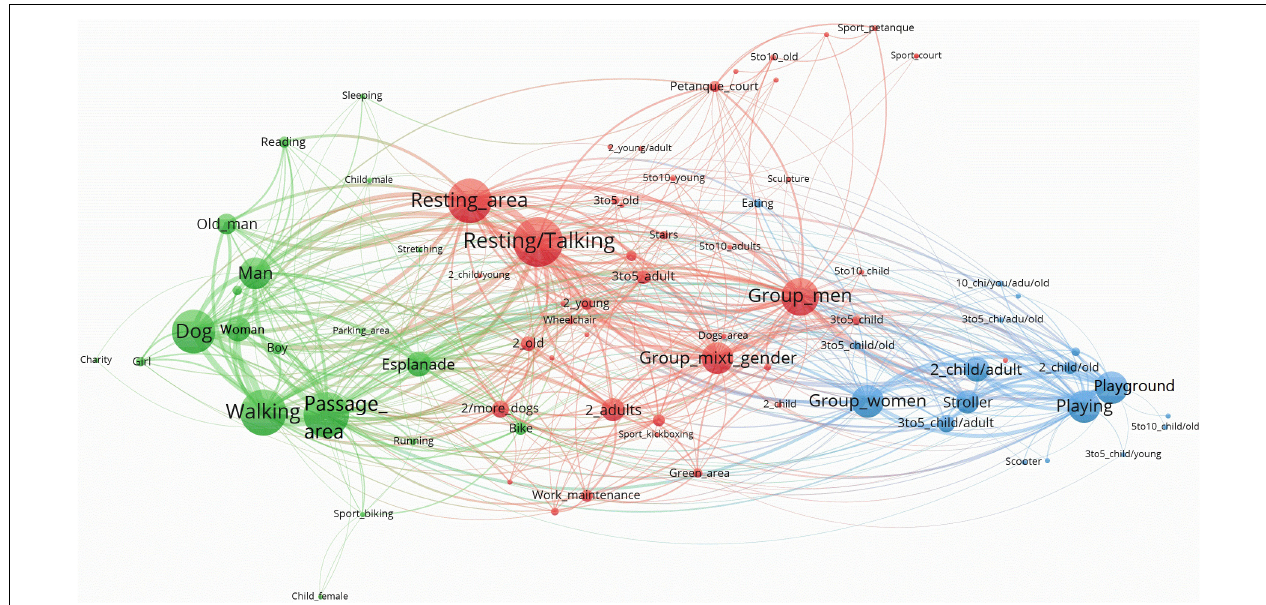
FIGURE 7 | Pegaso Park’s network by